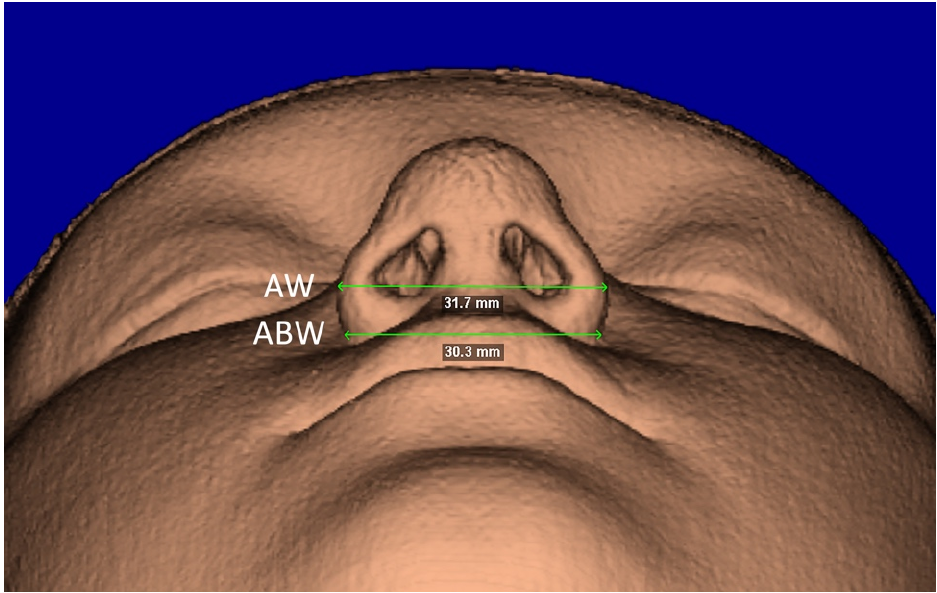
Figure 5. Facial soft-tissue linear measurements of the alar base width (ABW) and the alar width (AW).